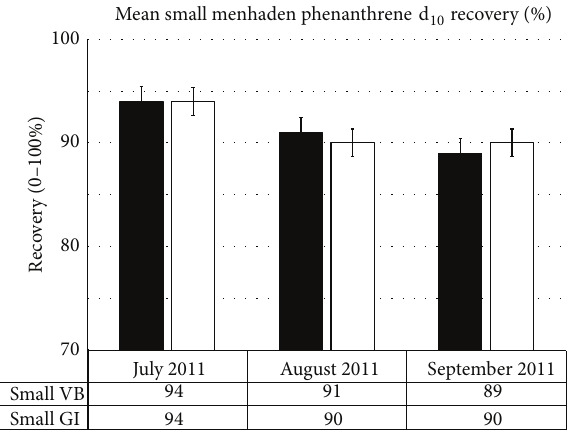
Figure 2: Mean “large” menhaden phenanthrene d 10 recoveries based on site and month of harvest, Summer 2011 (recoveries by month were not significantly different 𝛼 = 0.05 ).